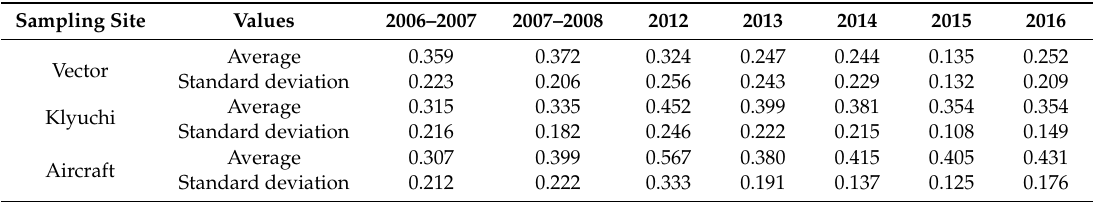
Table 1. The annual average values and standard deviations from them of the integral index of the microorganisms’ resistance to adverse environmental factors